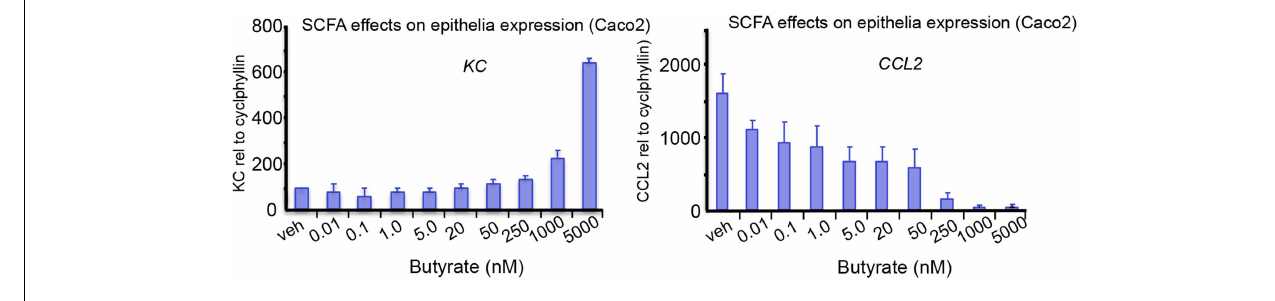
Expression levels of IL-8, and CCL2, were measured after 24h treatment. Butyrate modulates the epithelial responses to cytokines at relevant concentrations.Tytgat Institute,